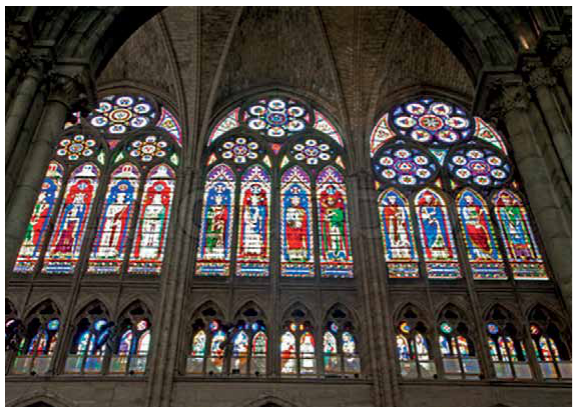
fig. 6. St. Dennis Cathedral, Paris. Source: